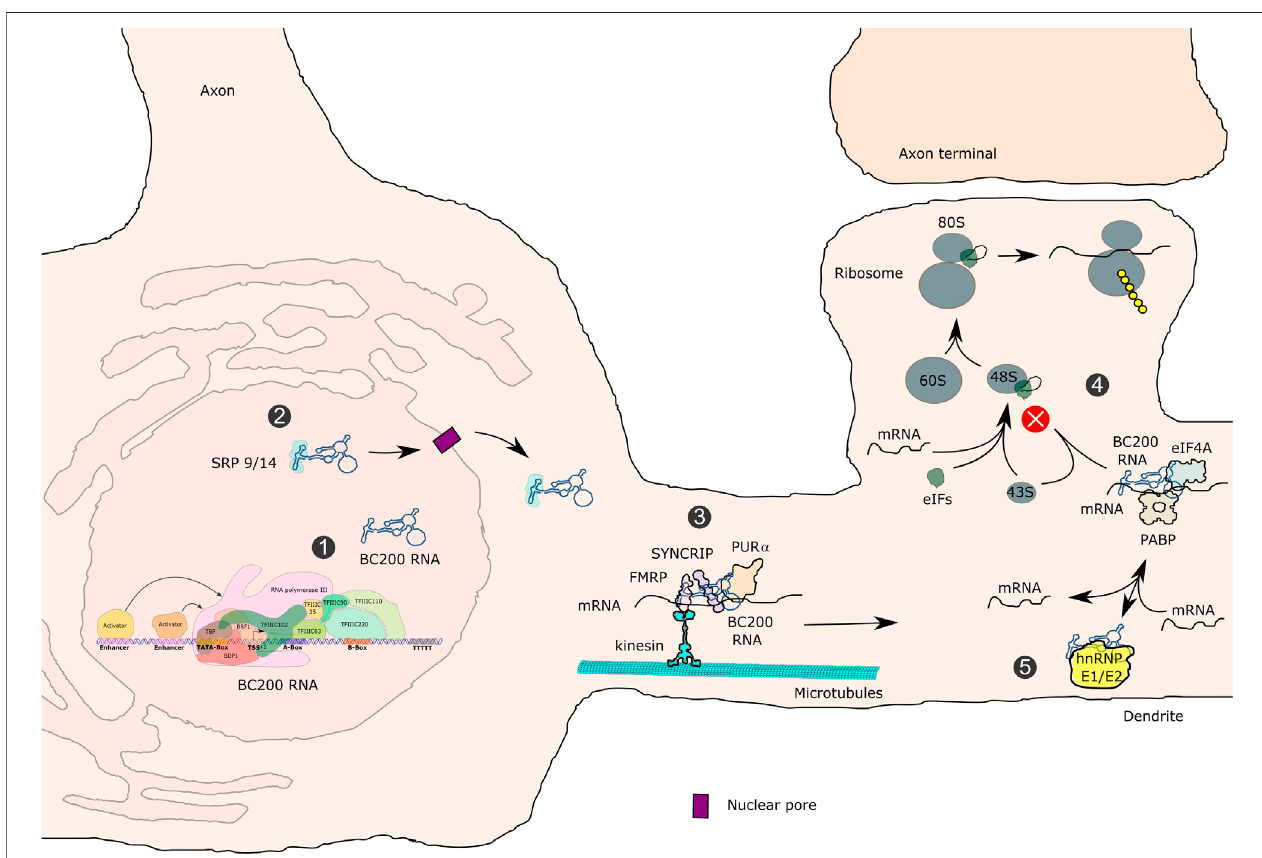
FIGURE 9 | Transcription of the BC200 RNA and its functions in mRNA transport and regulation of translation. BC200 RNA gene transcription depends on TFIIIC boundtogene-internalA-andB-boxes,whichallowsthesubsequentrecruitmentofTFIIIB- β andPolIII.SequencesupstreamoftheTSSincludingaTATA-likeboxat-30 regulatetranscriptionactivity(1).BC200RNAassembleswithSRP9/14inthenucleus(2)andisexportedtothecytoplasmwhereitwasshowntointeractwithavarietyof proteins. BC200 was shown to interact with FMRP, SYNCRIP and Pur-alpha, suggesting a role in mRNA transport similar to what was demonstrated for BC1 in complex with these proteins (3). In association with eukaryotic initiation factor 4A (eIF4A) and poly A binding protein (PABP), BC200 RNA prevents the assembly of the 48S ribosomal subunit (4). This repression of translation can be counteracted by hnRNP E1/E2 binding to BC200 RNA in vitro (5).